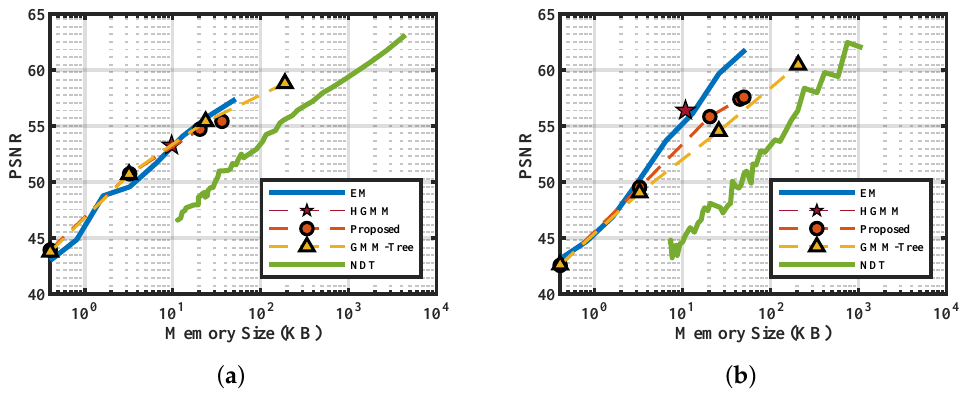
Figure 7. Peak Signal to Noise Ratio (PSNR) of the scenes selected from the Lidar datasets. ( a ) Street; ( b )